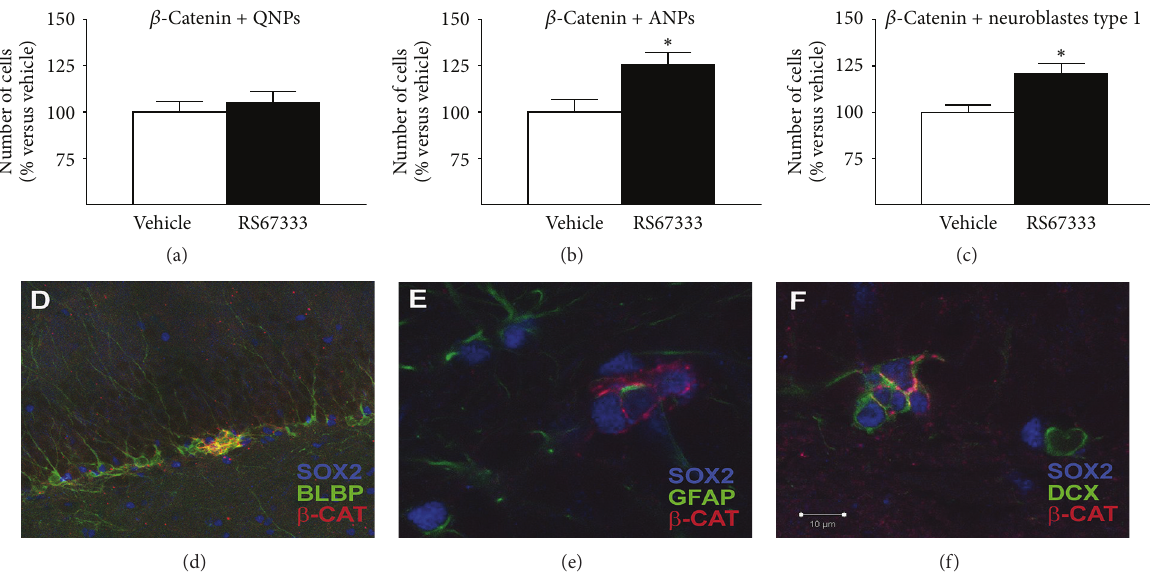
Figure 1: RS67333 increases the number of ANPs (b) and neuroblasts type 1 (c) that express 𝛽 -catenin, but not total number of QNPs cells (a). Photomicrographs illustrating 𝛽 -catenin expression in neural progenitors (d), ANPs (e), and neuroblasts (f). The results are the Mean ± S.E.M. ∗ 𝑃 < 0.05 versus vehicle. Bar: 10 𝜇 M, modified from Pascual-Brazo et al., 2012